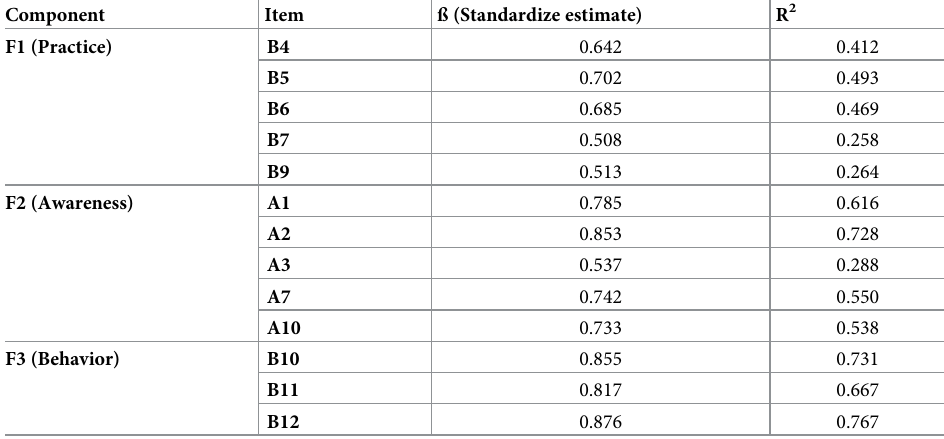
Table 5. Standardized regression weights on confirmatory factor analysis